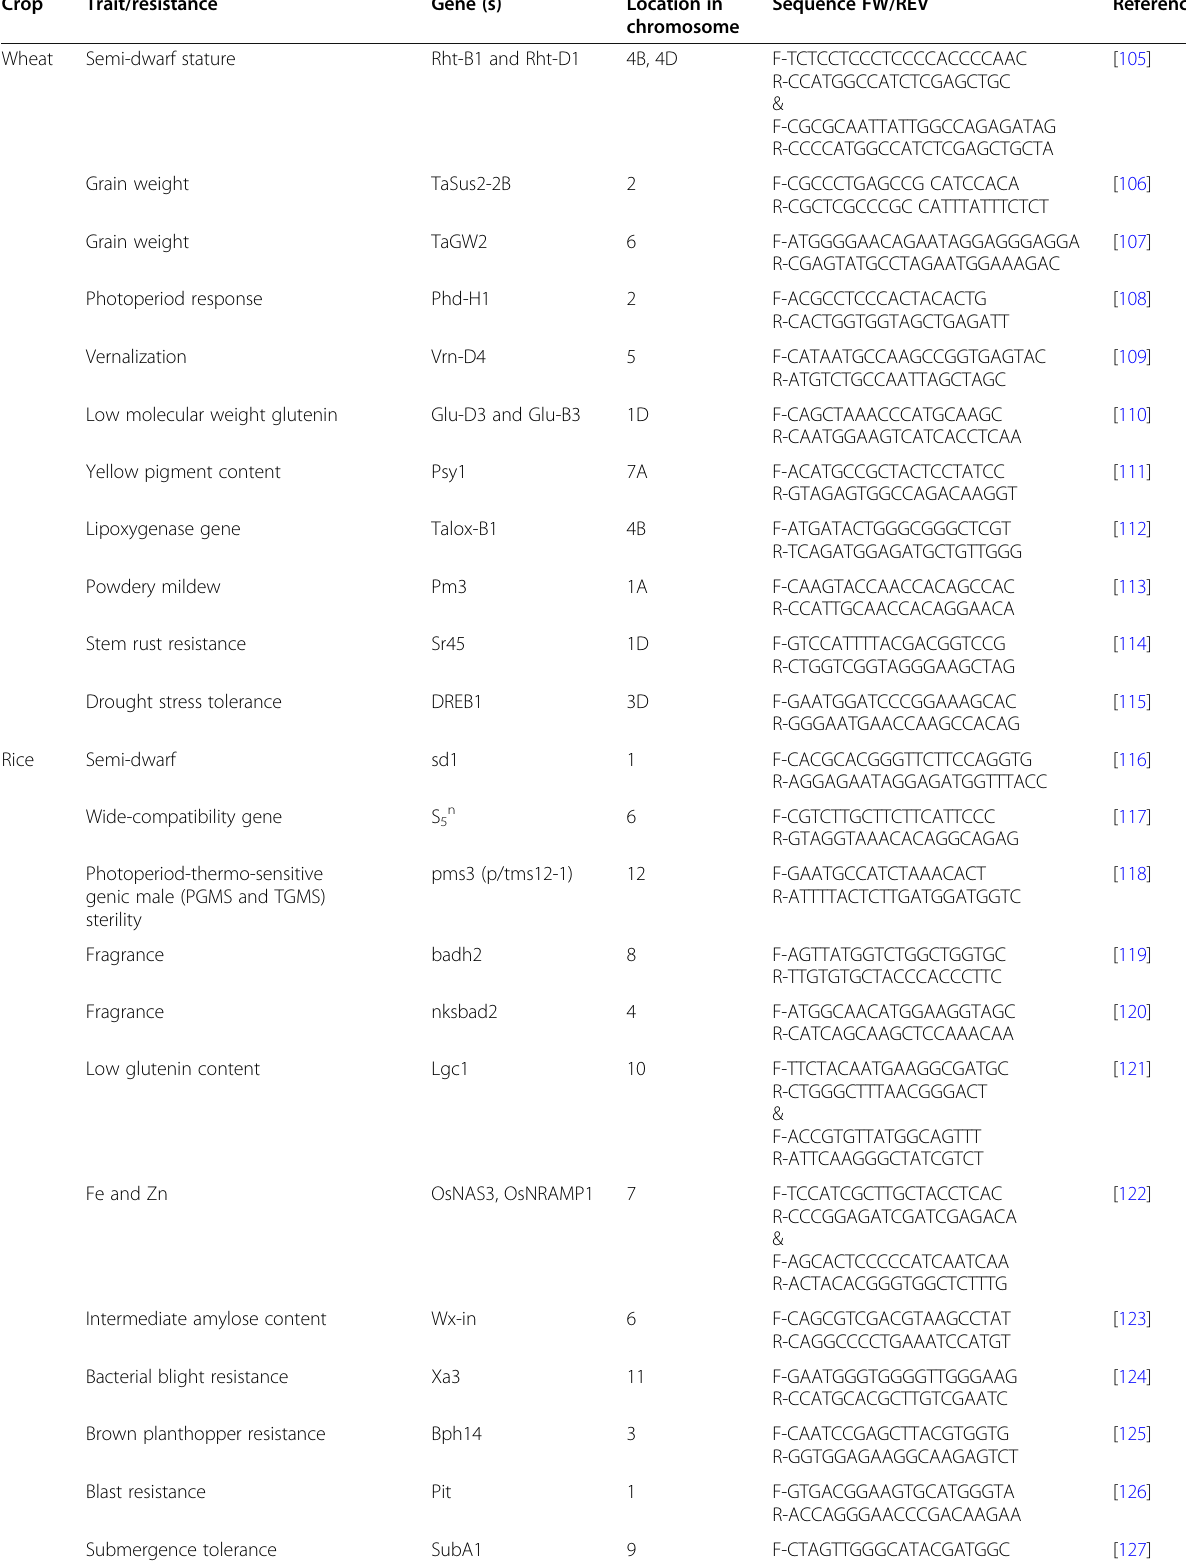
Table 5 Candidate genes for functional marker